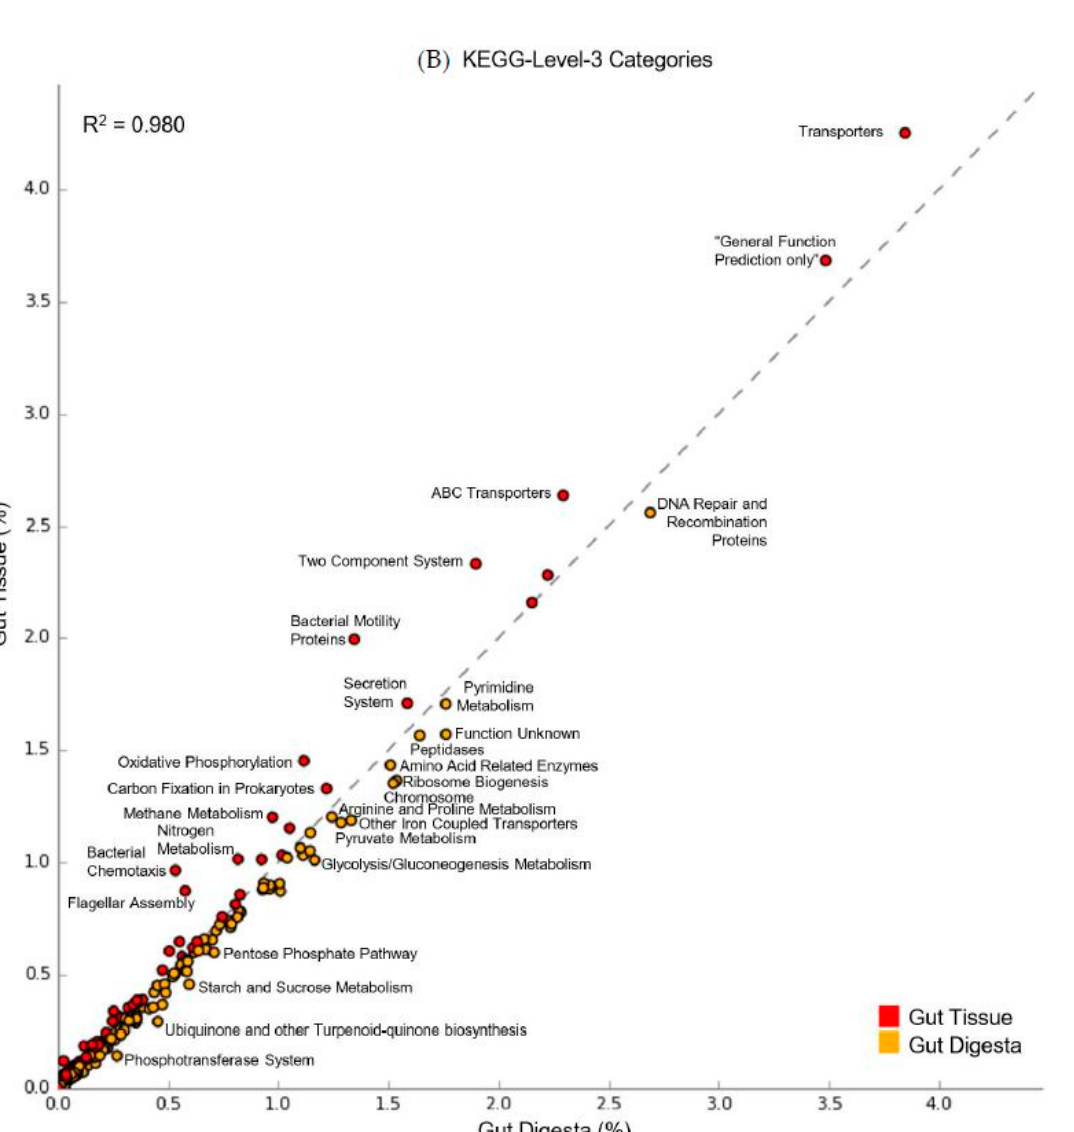
Figure 8. Scatter plot analysis of the predicted KEGG Orthology (KO) metabolic functions determined through Phylogenetic Investigation of Communities by Reconstruction of Unobserved States (PICRUSt v1.1.2) performed on the gut tissue ( n = 3) and gut digesta ( n = 3). Biological replicates were grouped, and analysis was performed for the ( A ) KEGG-Level-2 and ( B ) KEGG-Level-3 hierarchical functional categories. The linear regression value calculated for the two groups is shown for each scatter plot graph. Preferentially enriched categories for the gut tissue are shown as red, and for the gut digesta as brown. Those categories with clearly preferentially abundant categories have been labeled. Data were analyzed and visualized using STAMP (v2.1.3) analytical software. The node labels have been generated using scalable graphics, and therefore regions of interest can be viewed at a higher resolution digitally by increasing the magnification.